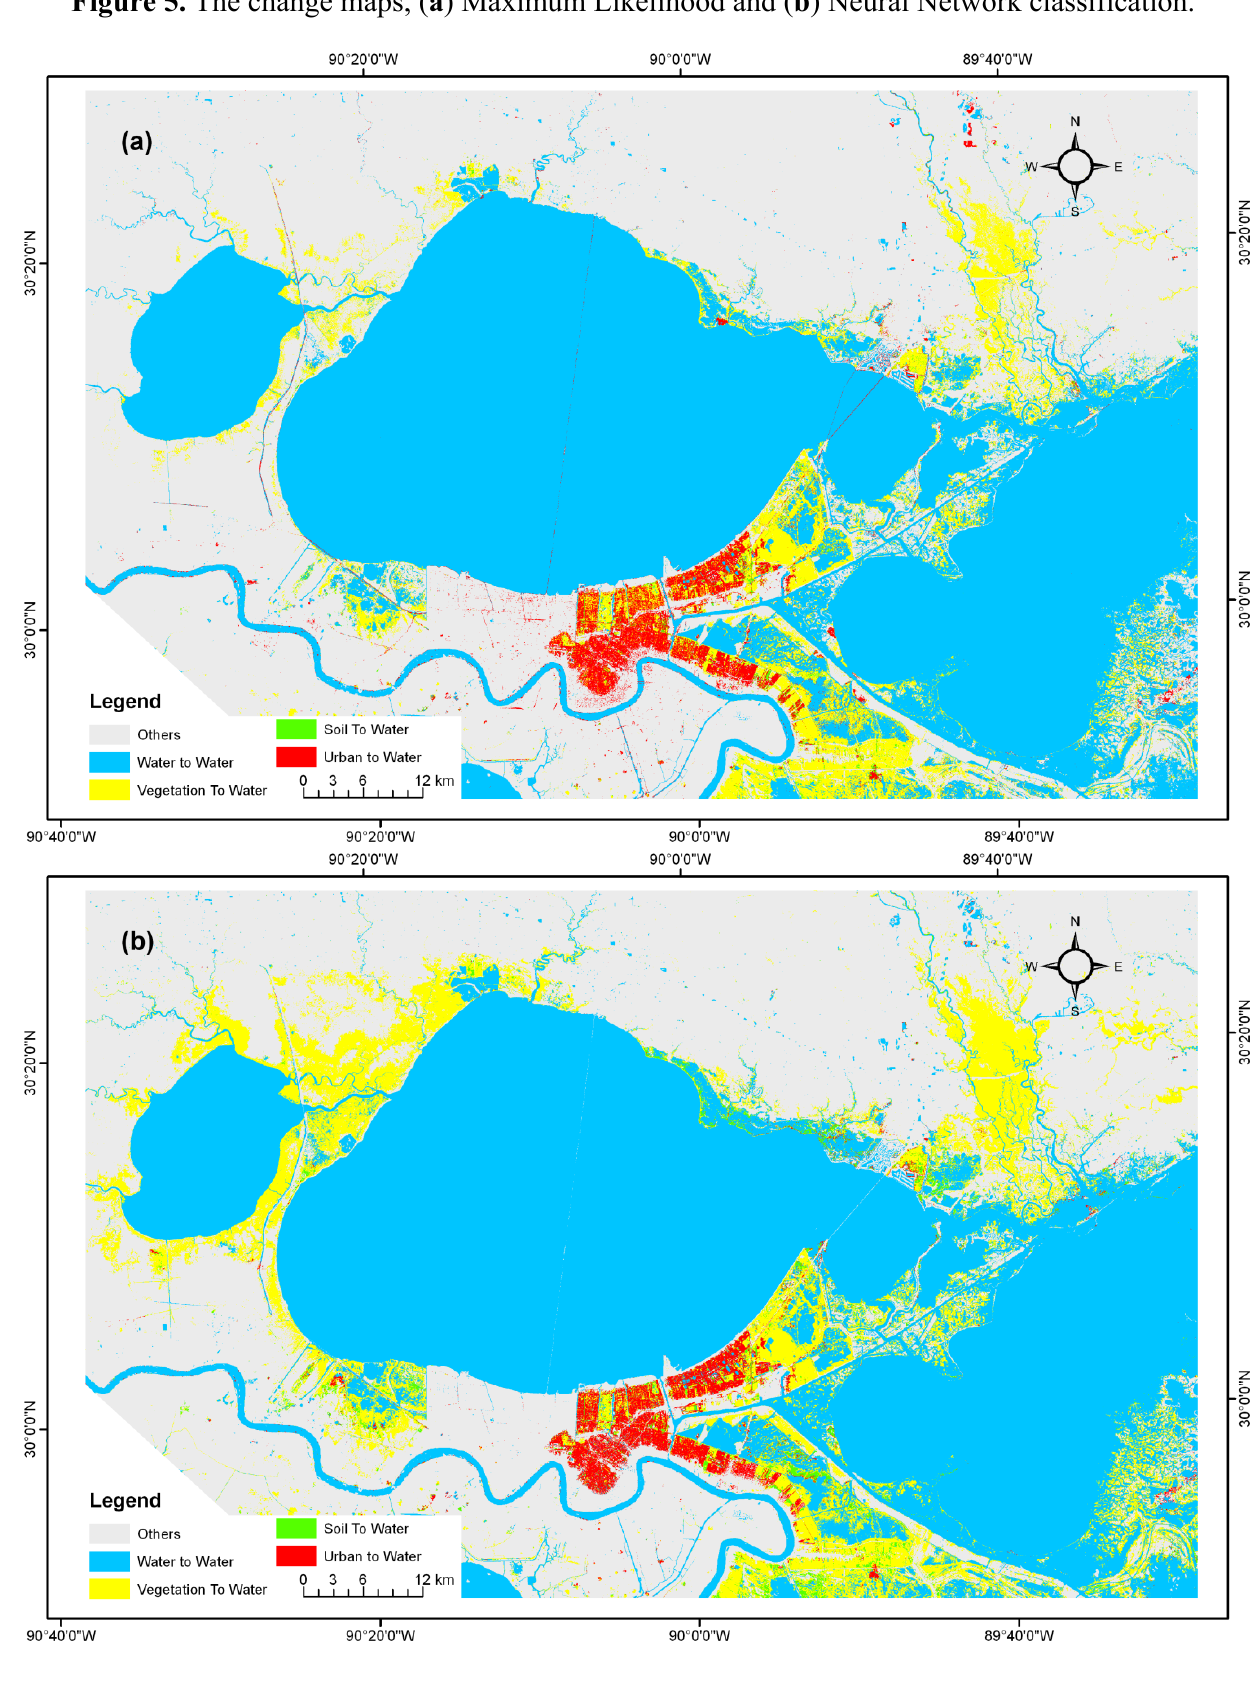
Figure 5. The change maps, ( a ) Maximum Likelihood and ( b ) Neural Network